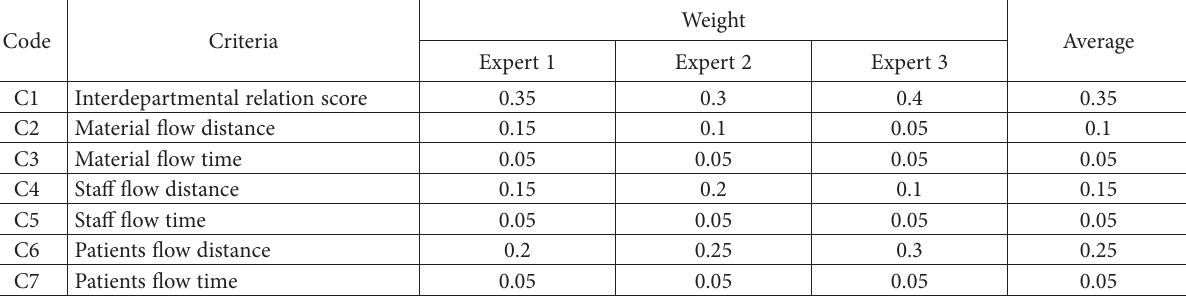
Table 11. Criteria weightage formulated with the help of experts